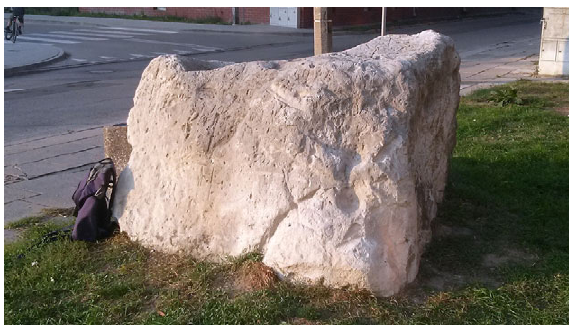
Fig. 8. Gaize with carbonate cement and preserved internal moulds is the third largest erratic in Pruszków; No. 3 in Table 2. Photo by M. Górska- Zabielska